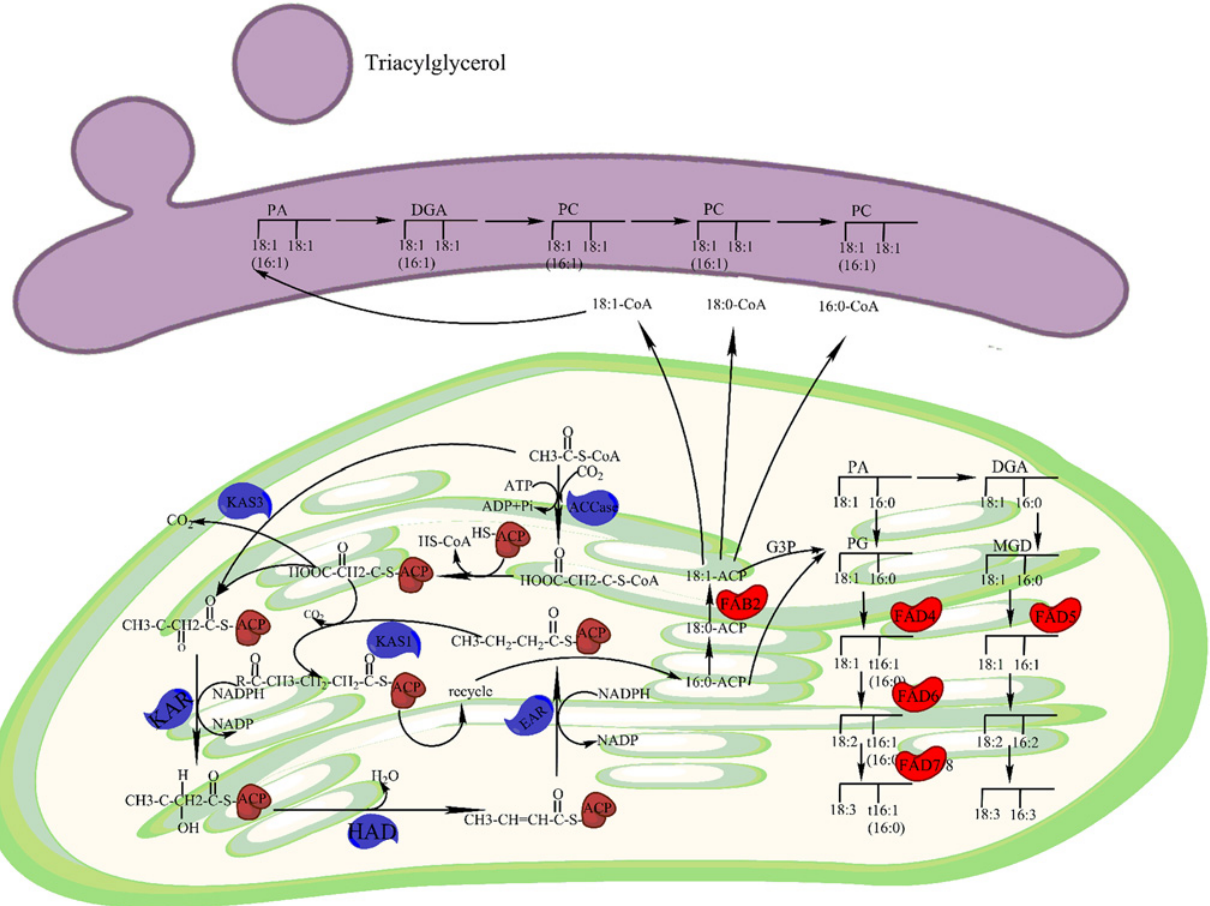
Fig 8. De novo fatty acid biosynthesis. Identified enzymes include ACCase, acetyl-CoA carboxylase carboxyl transferase (EC:6.4.1.2); KAS, 3-Ketoacyl ACP synthase (KASII, EC:2.3.1.179; KAS III, EC: 2.3.1.180); KAR, 3-Ketoacyl ACP reductase (EC:1.1.1.100); HAD, 3R-hydroxymyristoyl ACP dehydrase